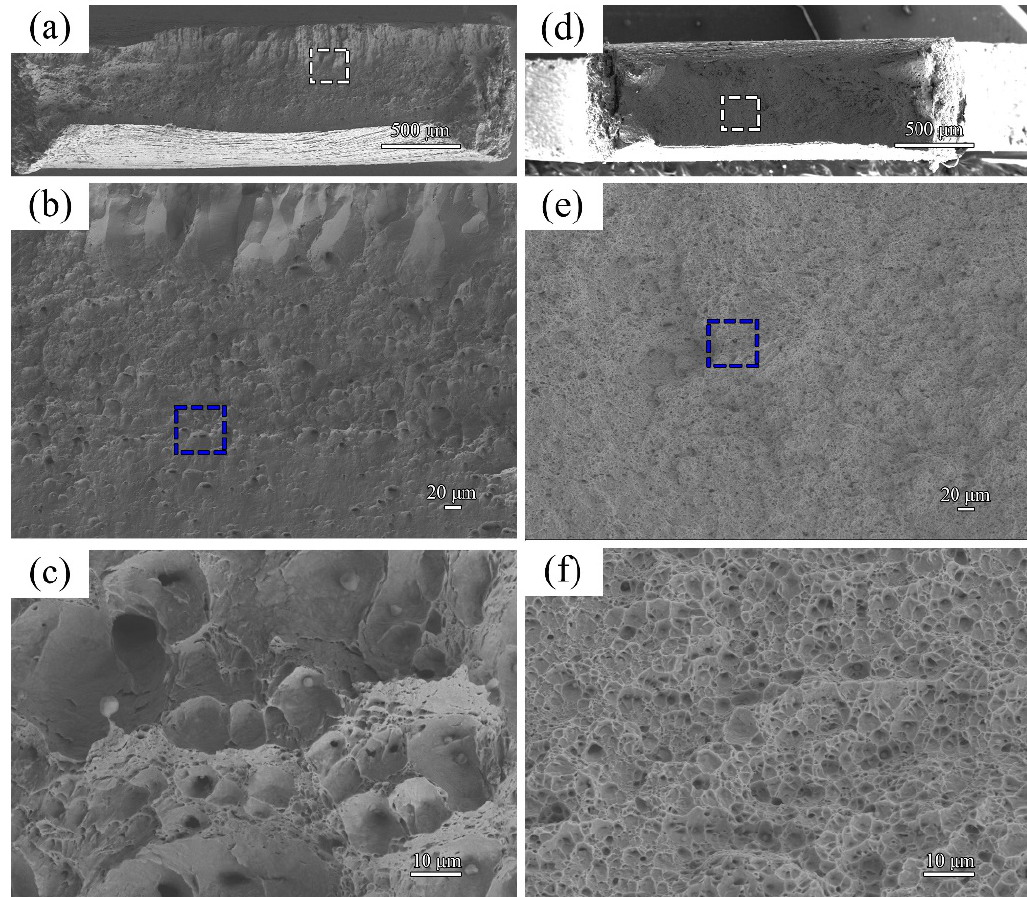
Figure 8. Fracture morphology of LSM process: ( a ) macrostructure of sample 1; ( b ) microstructure of white square in Figure 8a; ( c ) microstructure of blue square in Figure 8b; ( d ) macrostructure of sample 2; ( e ) microstructure of white square in Figure 8d; and ( f ) microstructure of blue square in Figure 8d.